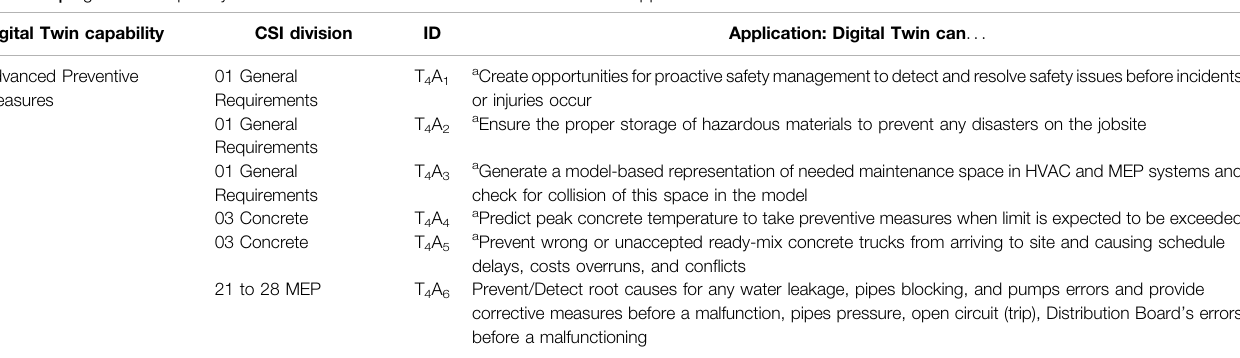
TABLE 6 | Digital Twin capability of Advanced Preventive Measures and the identi fi ed applications. Digital Twin